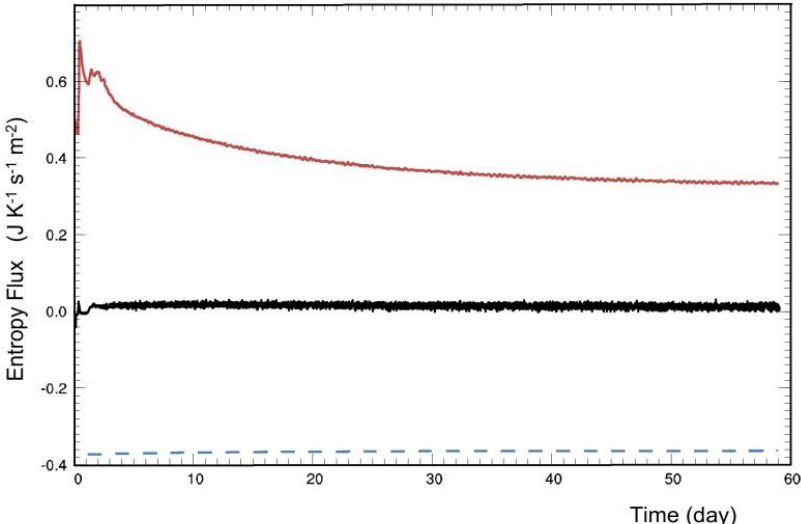
Figure 2. Time series of three entropy fluxes in the approach of the RCE: (red) the flux of entropy from the sea to air, (blue) the flux of entropy from the air to space due to radiative cooling and (black) the total internal generation of entropy due to mixing and rainwater evaporation.